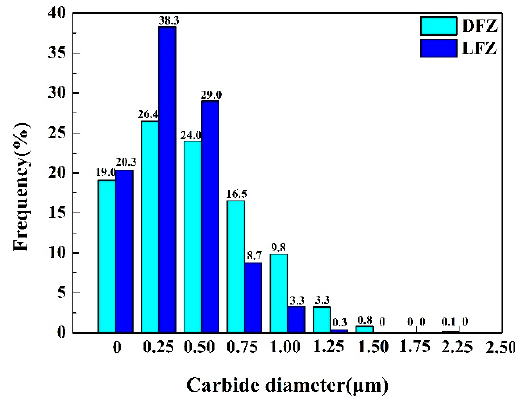
Figure 5. Distribution of carbide diameter in the DFZ and LFZ.